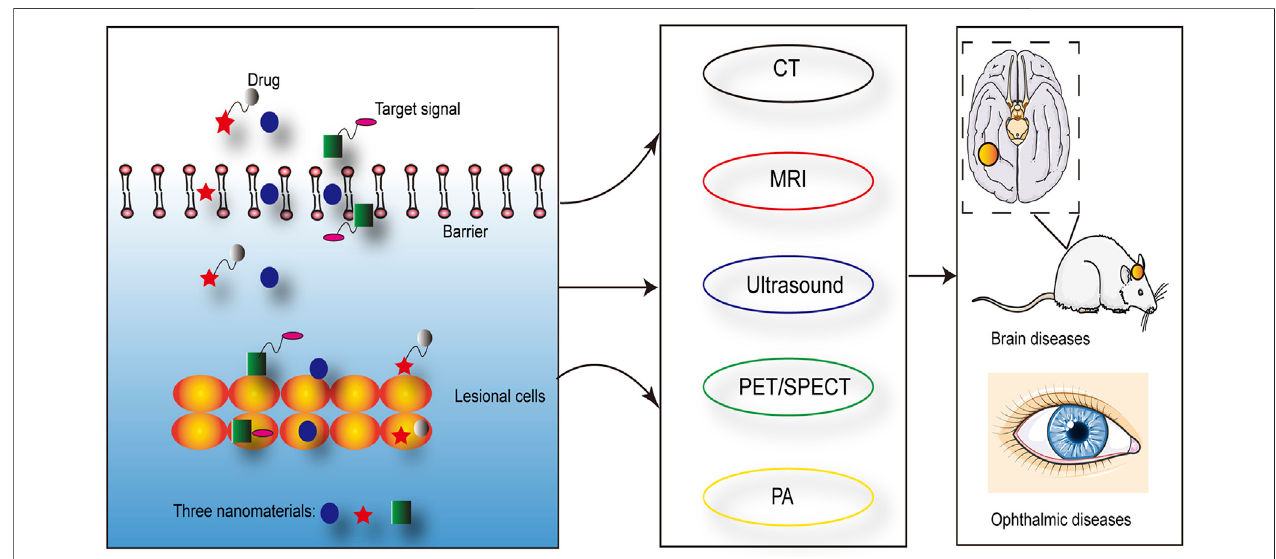
FIGURE 2 | Nanomaterials could effectively pass through barriers in vivo and achieve the targeting of lesional cells, which were visualized by the imaging techniques.